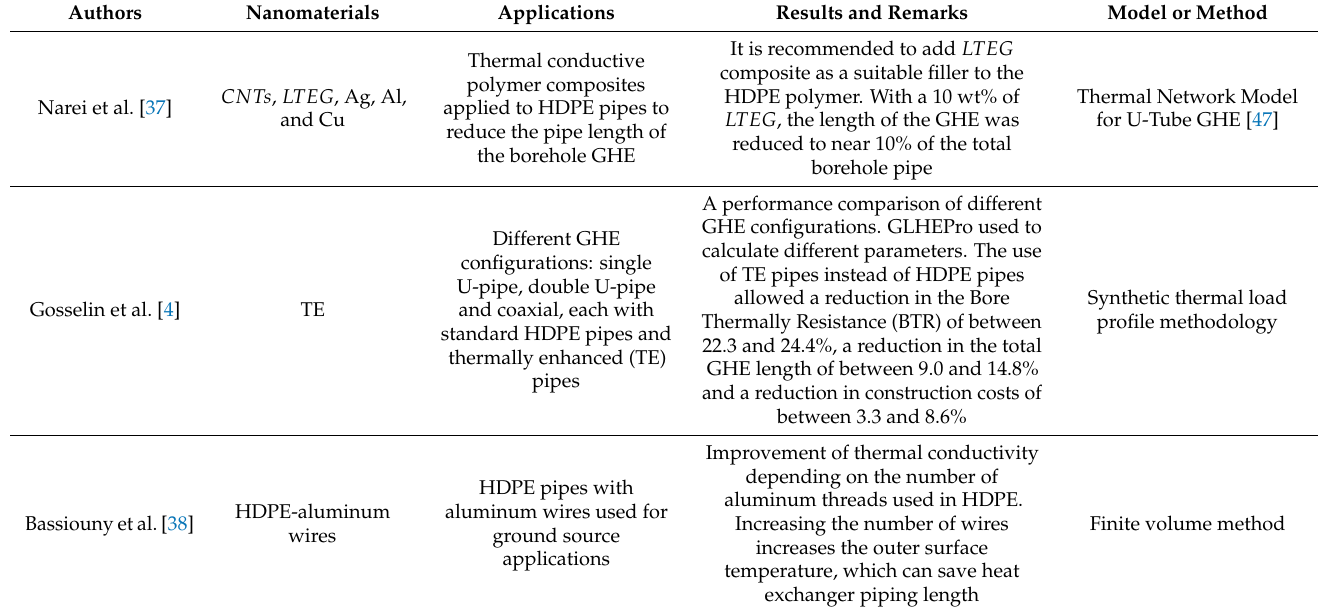
Table 4. Summary of theoretical and numerical studies on heat exchanger pipes using